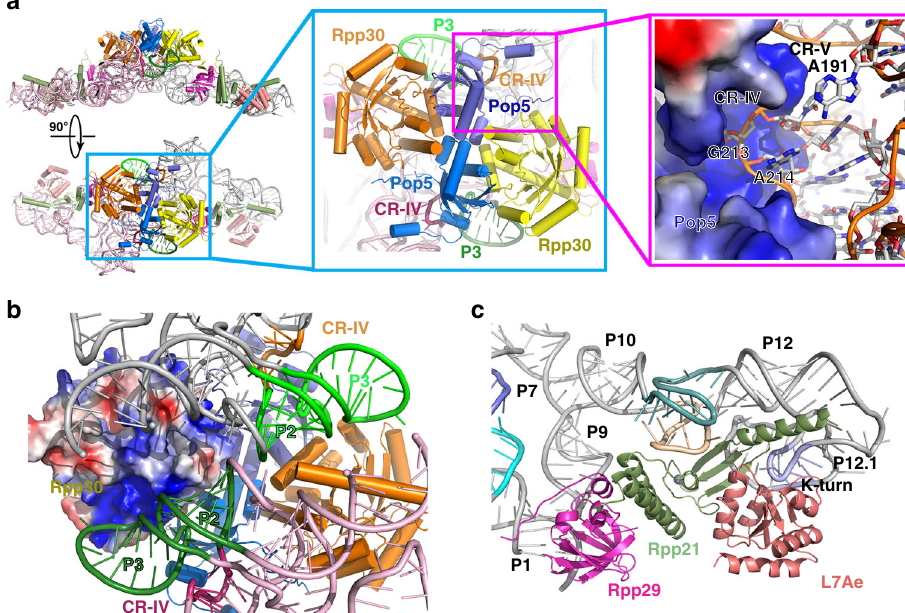
Fig. 5 Interaction between RPR and RPPs in Mja RNase P. a Left: The atomic model of the Mja RNase P complex is shown in two orthogonal views. RPPs are color-coded as in Fig. 2a. The two RPR molecules are colored in pink and gray, respectively. Middle: Close-up view of the interface between two RPRs (colored in pink and gray) and the (Pop5-Rpp30) 2 heterotetramer. The two P3 stems are colored in deepteal and green, respectively. Right: Close-up view of the interface between Pop5 and CR-IV of RPR. Pop5 is shown in electrostatic surface representation and RPR in cartoon representation. b Rpp30 simultaneously interacts with the two RPR molecules in the dimeric holoenzyme. One Rpp30 is shown in electrostatic surface representation and the interacting P2-P3 stem from one RPR is colored in deepteal and the other interacting RPR in green. c Close-up view of the interface between the Rpp29- Rpp21-L7Ae heterotrimer and RPR. RPR and RPPs are shown in cartoon and colored as in Fig. 3c and Fig. 2a,